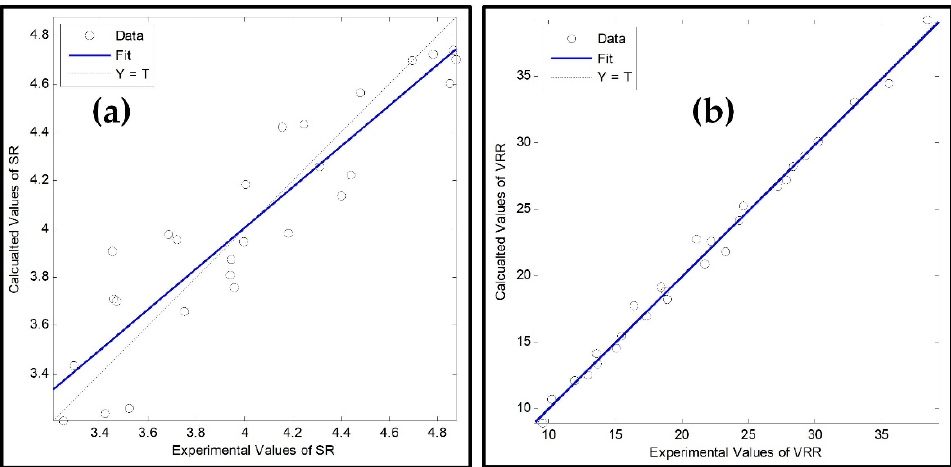
Figure 4. Experimental vs calculated values of ( a ) SR and ( b ) VRR using MLRM.